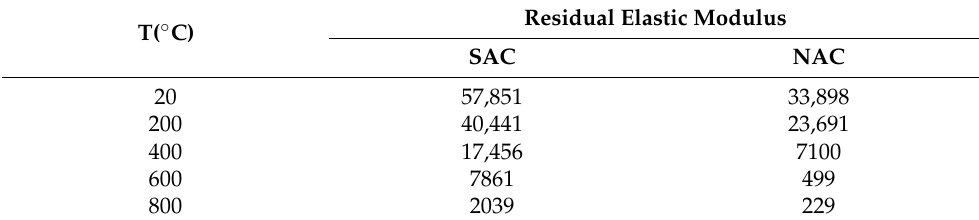
Table 5. Residual elastic modulus of concrete after different